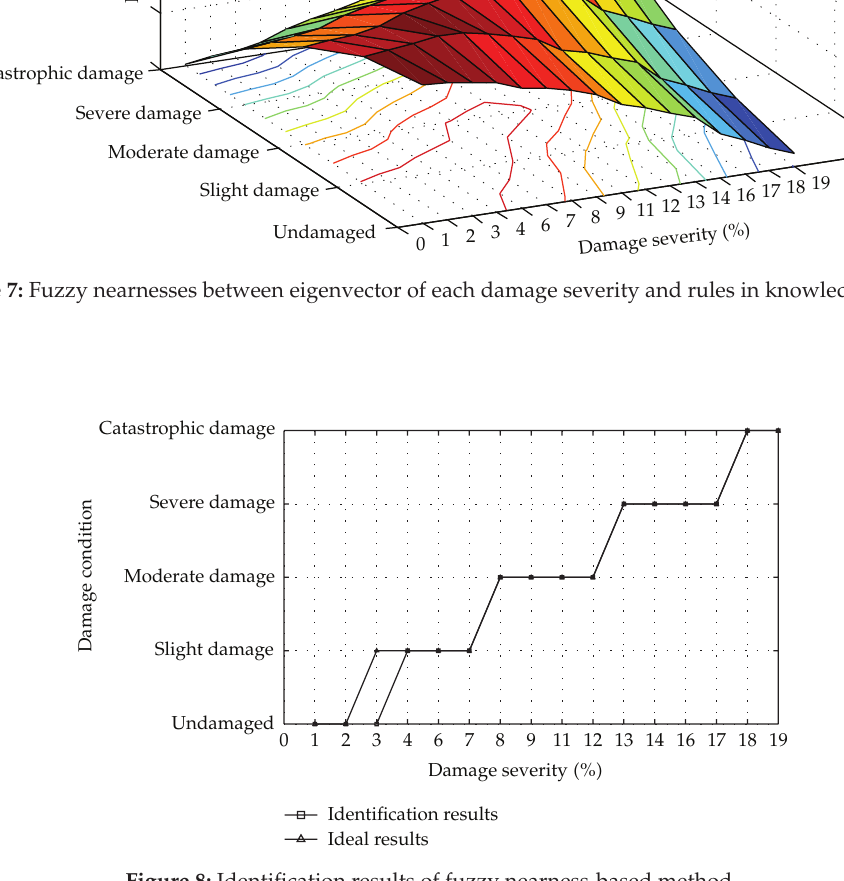
Figure 8: Identification results of fuzzy nearness-based